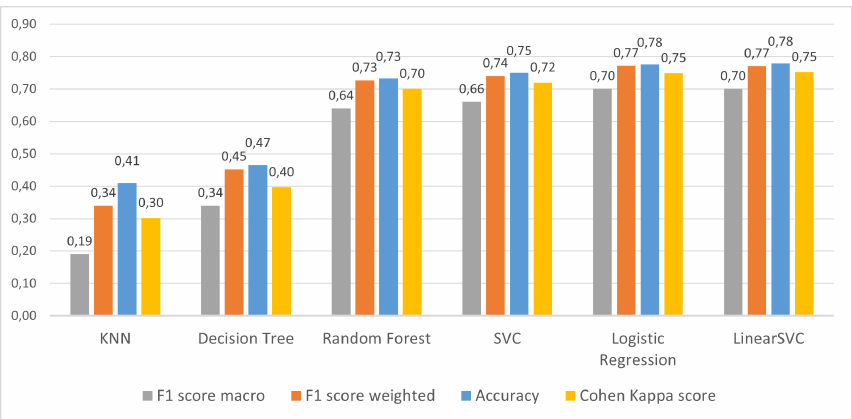
Figure 6. Cuisine classifier